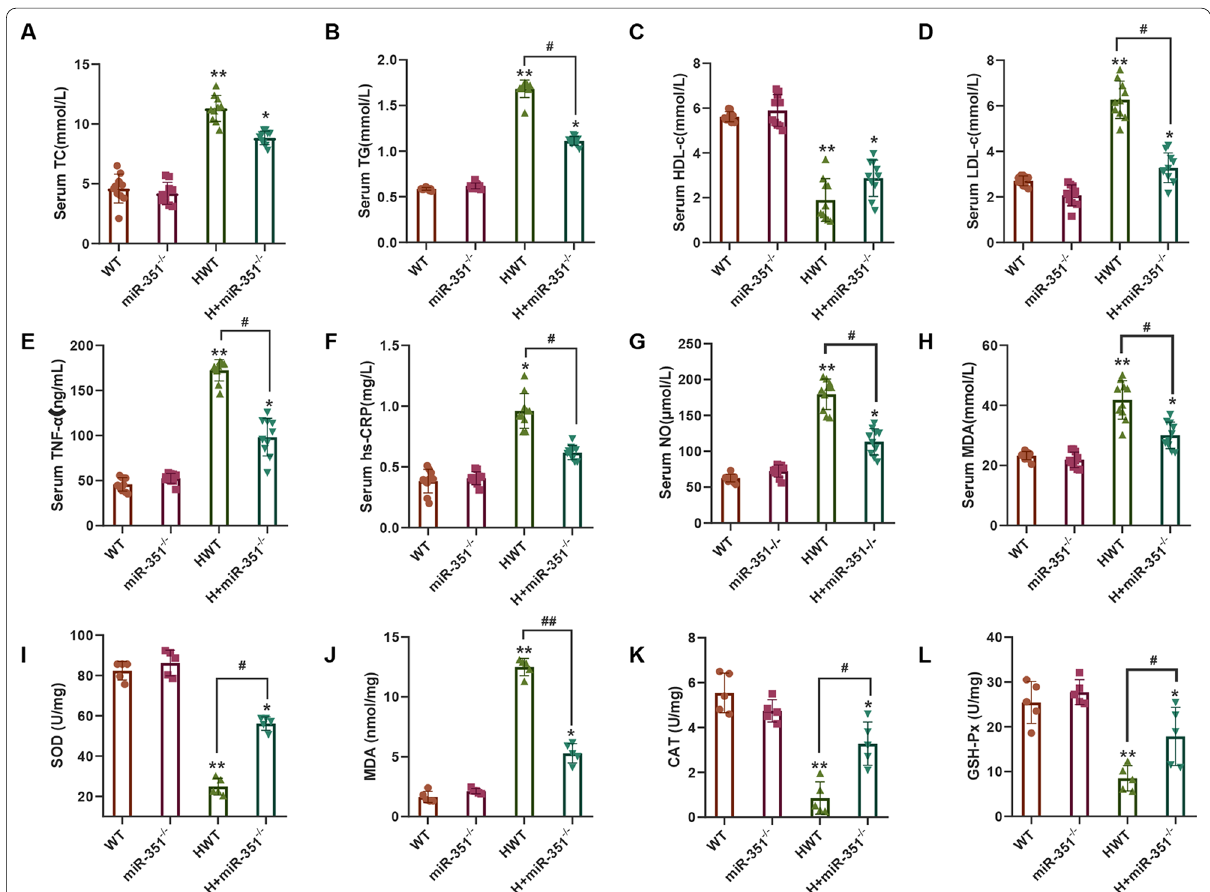
Fig. 2 Serum and tissue biochemical tests. A Serum total cholesterol (TC) levels were detected. B Serum triglyceride (TG) levels were detected. C Serum high-density lipoprotein cholesterol (HDL-c) levels were measured. D Serum low-density lipoprotein cholesterol (LDL-c) levels were detected. E Serum tumor necrosis factor α (TNF-α) was detected. F Serum hs-CRP levels were detected. G Serum nitric oxide (NO) levels were detected. H Serum malondialdehyde (MDA) levels were detected. I Detection of superoxide dismutase (SOD) activity in aortic tissue. J Detection of MDA levels in aortic tissue. K CAT activity in aortic tissue was measured. L Glutathione peroxidase (GSH-Px) activity in aortic tissue was detected. ** P < 0.01 * P < 0.05, vs. WT group. # P < 0.05 represents the comparison between the two groups of connections. (Serum test, N detection, N 5 mice per =